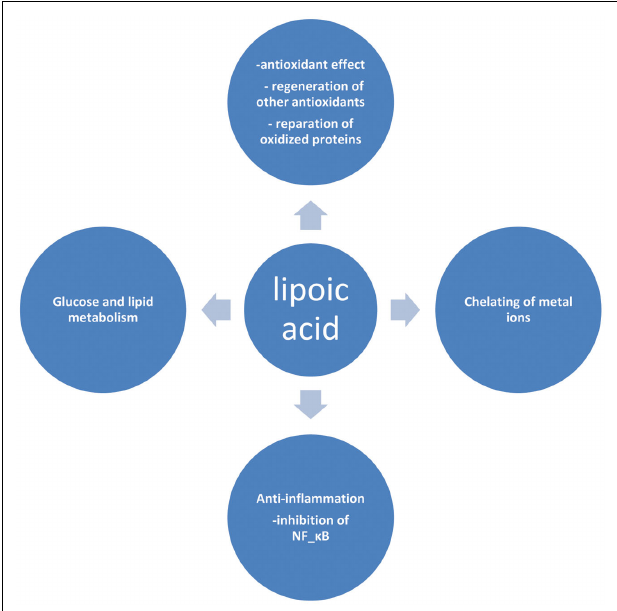
FIGURE 1 | Selected biological actions of lipoic